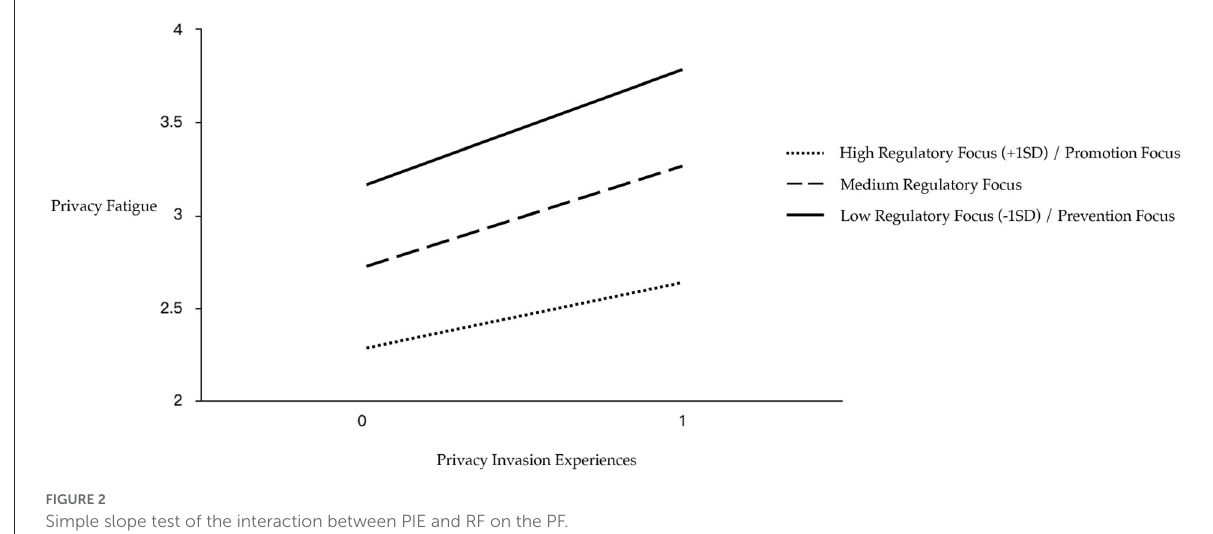
FIGURE2 Simple slope test of the interaction between PIE and RF on the PF.